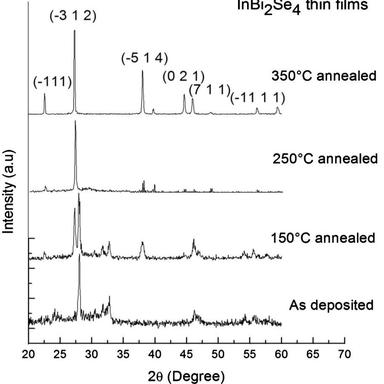
XRD analysis for Indium bismuth selenide.